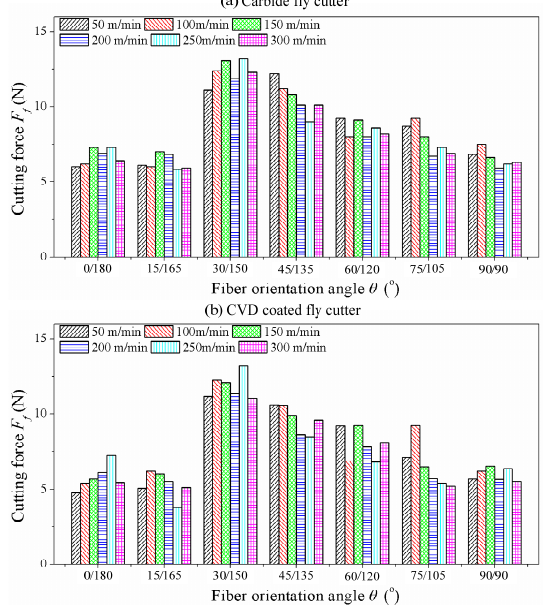
Figure 8. Cutting force results of carbide tool and diamond coating tool. ( a ) Carbide fly cutter; ( b ) CVD coated fly cutter.